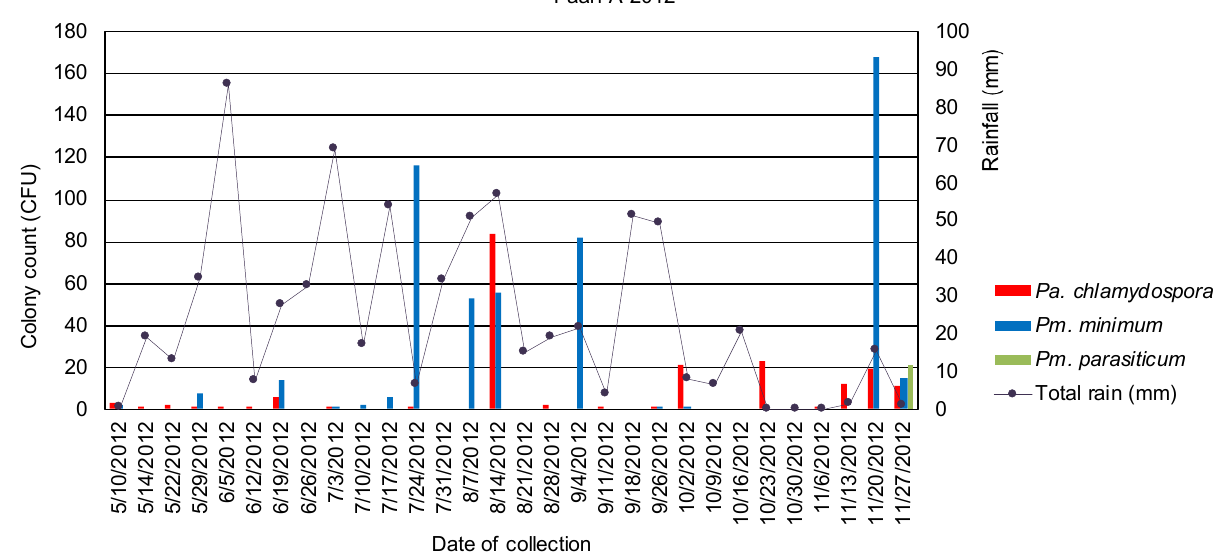
Figure 1. Phaeomoniella and Phaeoacremonium spp. cfu cultured from five vaseline coated microscope slides affixed to the cordons on each of five vines in vineyard Paarl A, Western Cape province in 2012. The slides were replaced weekly. Each bar represents the total number of cfu cultured on three Petri